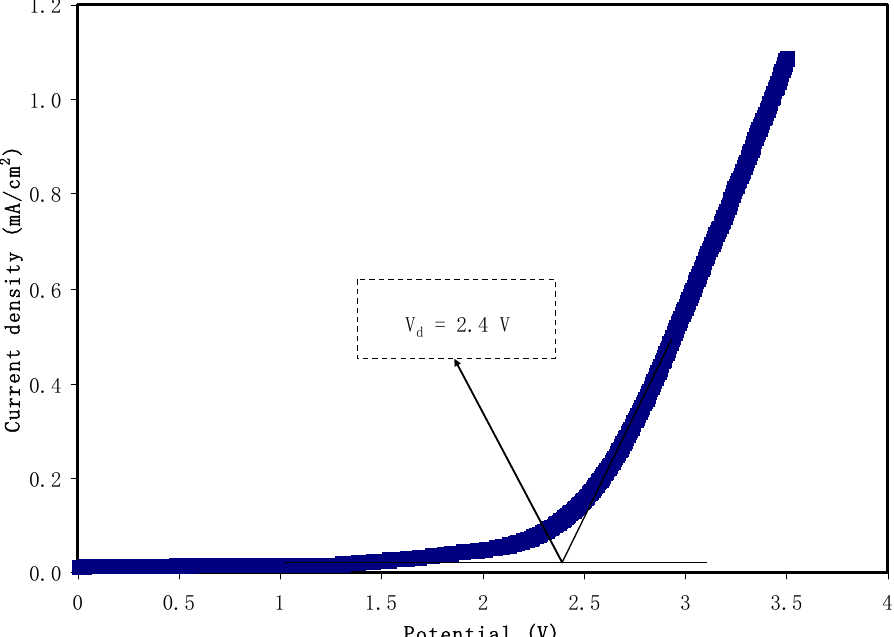
Figure 7. LSV plot for CSPVMG3 at a scan rate of 20 mV/s.